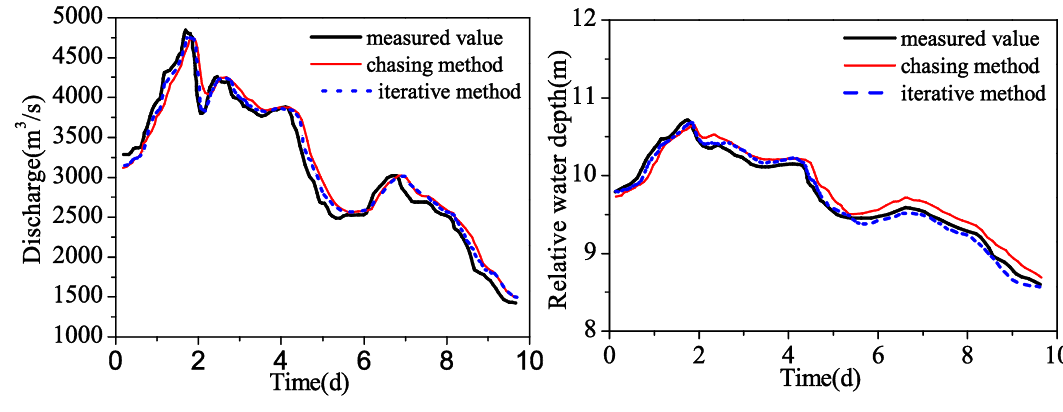
Fig. 11 Verification of the calculated flow rate and water level in Shimen